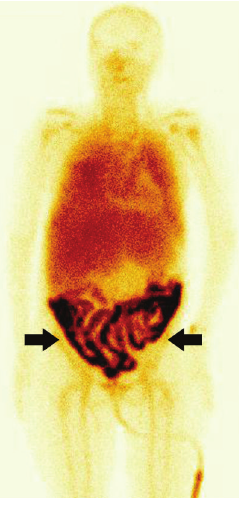
Figure 5: 53-year-old woman with fever of unknown origin without abdomen pain. Whole body inflammation imaging with patient leukocytes labelled by means of 99 m Tc-HMPAO, anterior view.